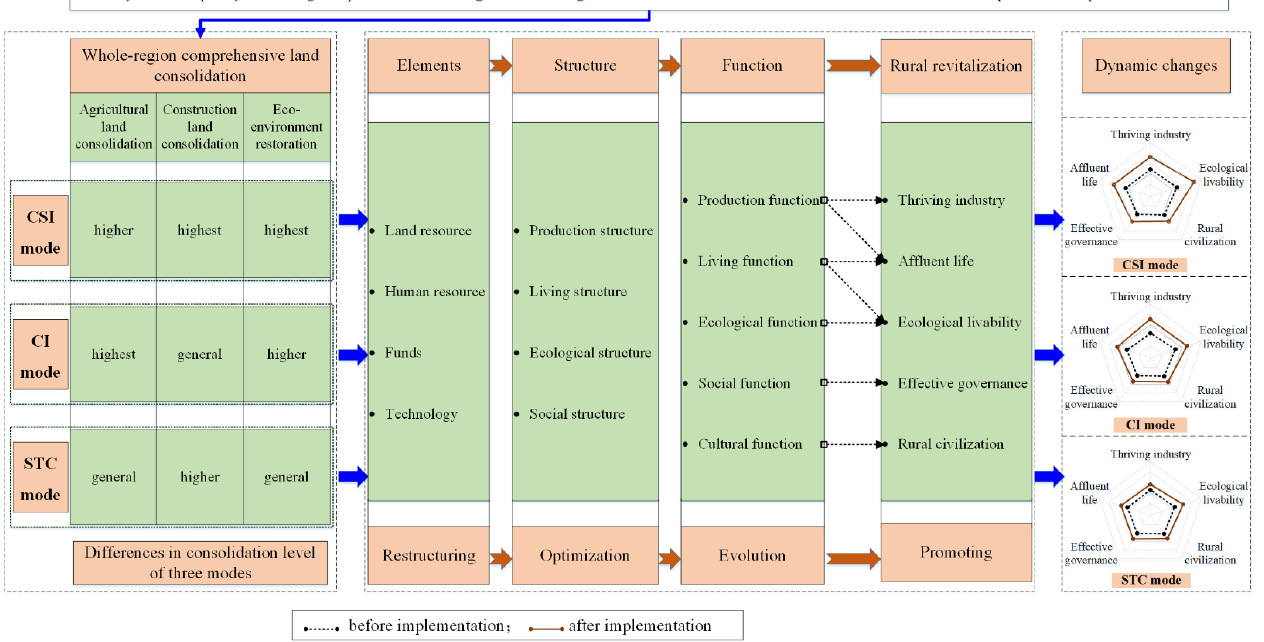
Figure 1. Internal logic of whole-region comprehensive land consolidation promoting rural revital- ization. Note: 1. SI-mode, CI-mode, and STC-mode, respectively, refer to city-suburb integration mode, characteristic industry mode, and small-town construction mode. 2. The highest, higher, and general, respectively, refer to the degree of consolidation of agricultural land (construction land and eco-environment) by the three typical consolidation